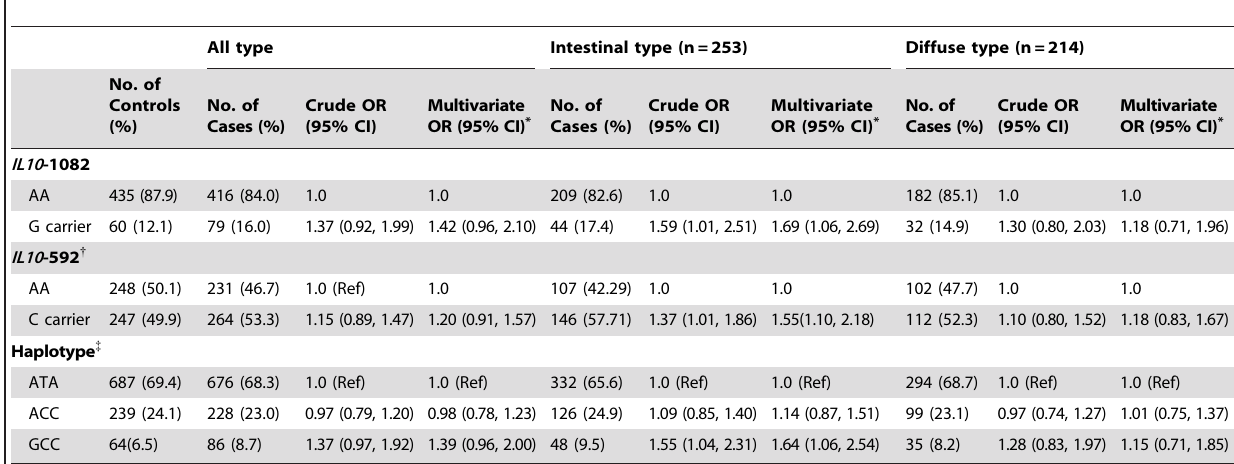
Table 2. The Association between IL10 Genetic Variants and the Risk of Gastric Cancer, Stratified by Histological Type of Noncardia Gastric Cancer.